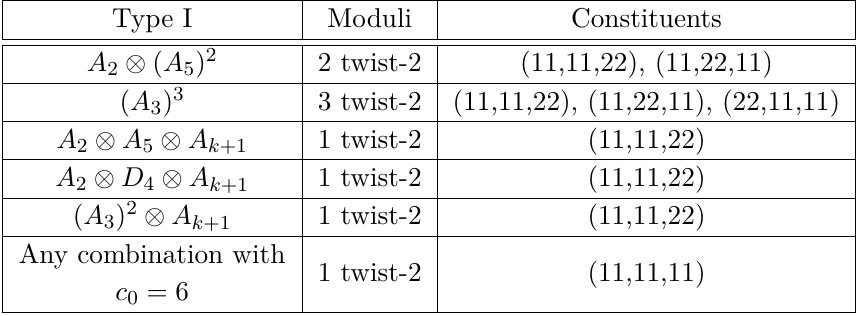
Table 2 . Overview of the different single-trace twisted operators for sparse theories with three minimal models in the tensor product, with c